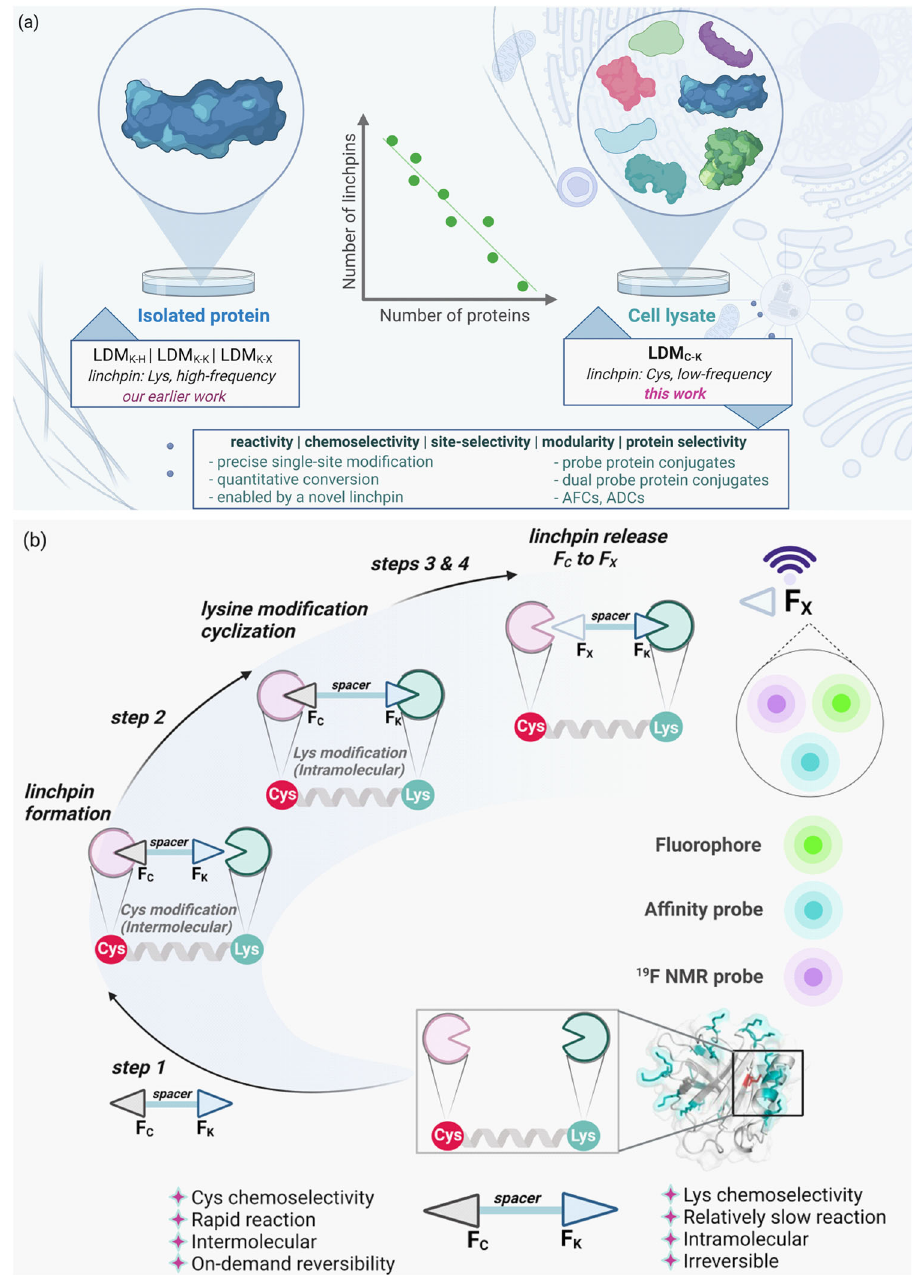
Fig. 1 | Chemical technology for precision engineering of native proteins. a Requirement: low-frequency residue-derived proximity regulator to create a unique targetable landscape and opportunity for simultaneous regulation of reactivity, chemoselectivity, site-selectivity, modularity, and protein-selectivity. b Hypothesis: Cys-linchpin-directed modi fi cation of Lys residue (LDM C-K ). Step 1,